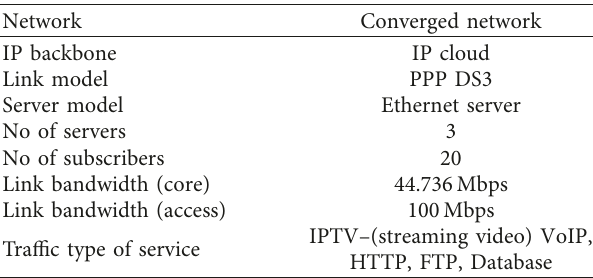
Figure 4: The OPNET simulation model of a converged network. Table 1: Parameters for simulating converged